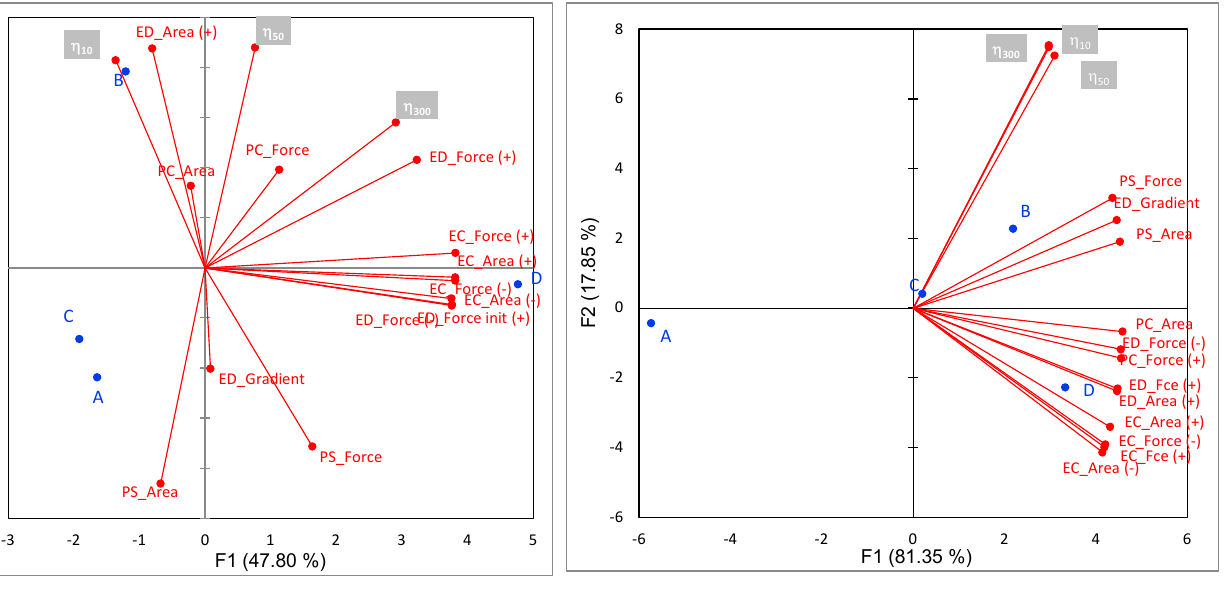
Figure 3. PCA plot of texture and rheological measurement for the four thickeners at two consistency levels: nectar and pudding. EC—extrusion with cone, ED—extrusion with disc, PC—penetration with cylinder, PS—penetration with the sphere. In blue color are the samples and in the grey boxes are the apparent viscosities at different shear rates (10, 50, and 300 s −1 ) (Thickeners: A, B, C, D). For the nectar level, PC1 distributes the samples by the texture analyzer results, sep- arating sample D with the highest values of extrusion forces, penetration forces, and adhesivity values (force and area obtained with extrusion with cone) from the rest. PC2 sep- arates the samples by viscosity; so, B is the sample with the highest viscosity (obtained with the rheometer) and highest consistency (positive area values obtained by disc